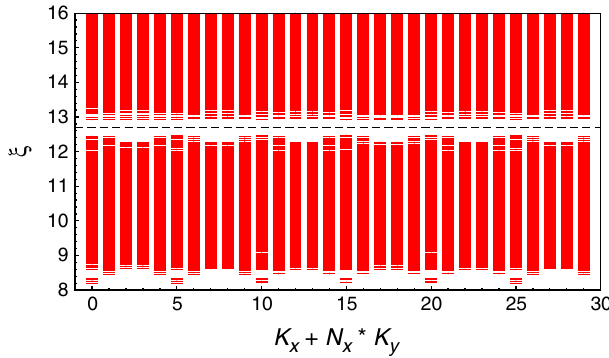
FIG. 12. Particle entanglement spectrum for N ¼ 10 , N x ¼ 5 , 6 , and N 5 . The (cid:9) ’s are the entanglement energies. The N y ¼ A ¼ number of states below the dashed line is 776 in all the k x ¼ 0 , and 775 in the other sectors. This is in agreement with the (1,3) Pauli principle for every momentum sector.